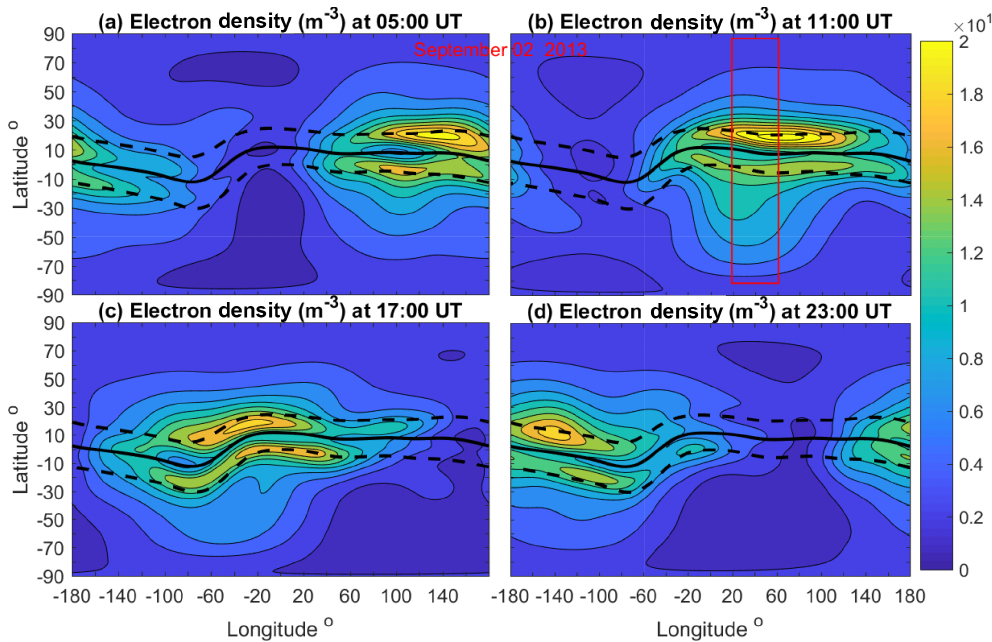
Figure 3. Panels (a) , (b) , (c) and (d) present the global distribution of electron density derived from the IRI model at 05:00, 11:00, 17:00 and 23:00UT, respectively on 2 September 2013. The black solid and dotted lines indicate the locations of the magnetic equator and the crests of the EIA. The red box indicates the longitude sector of the current study